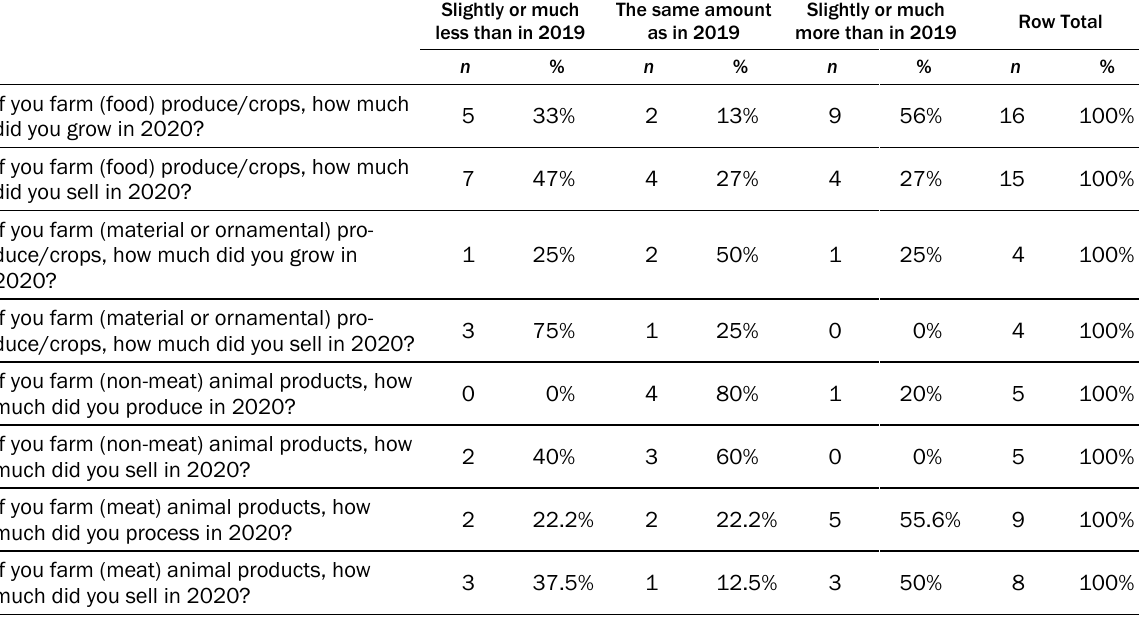
Table 5. Production, Processing, and Sales in